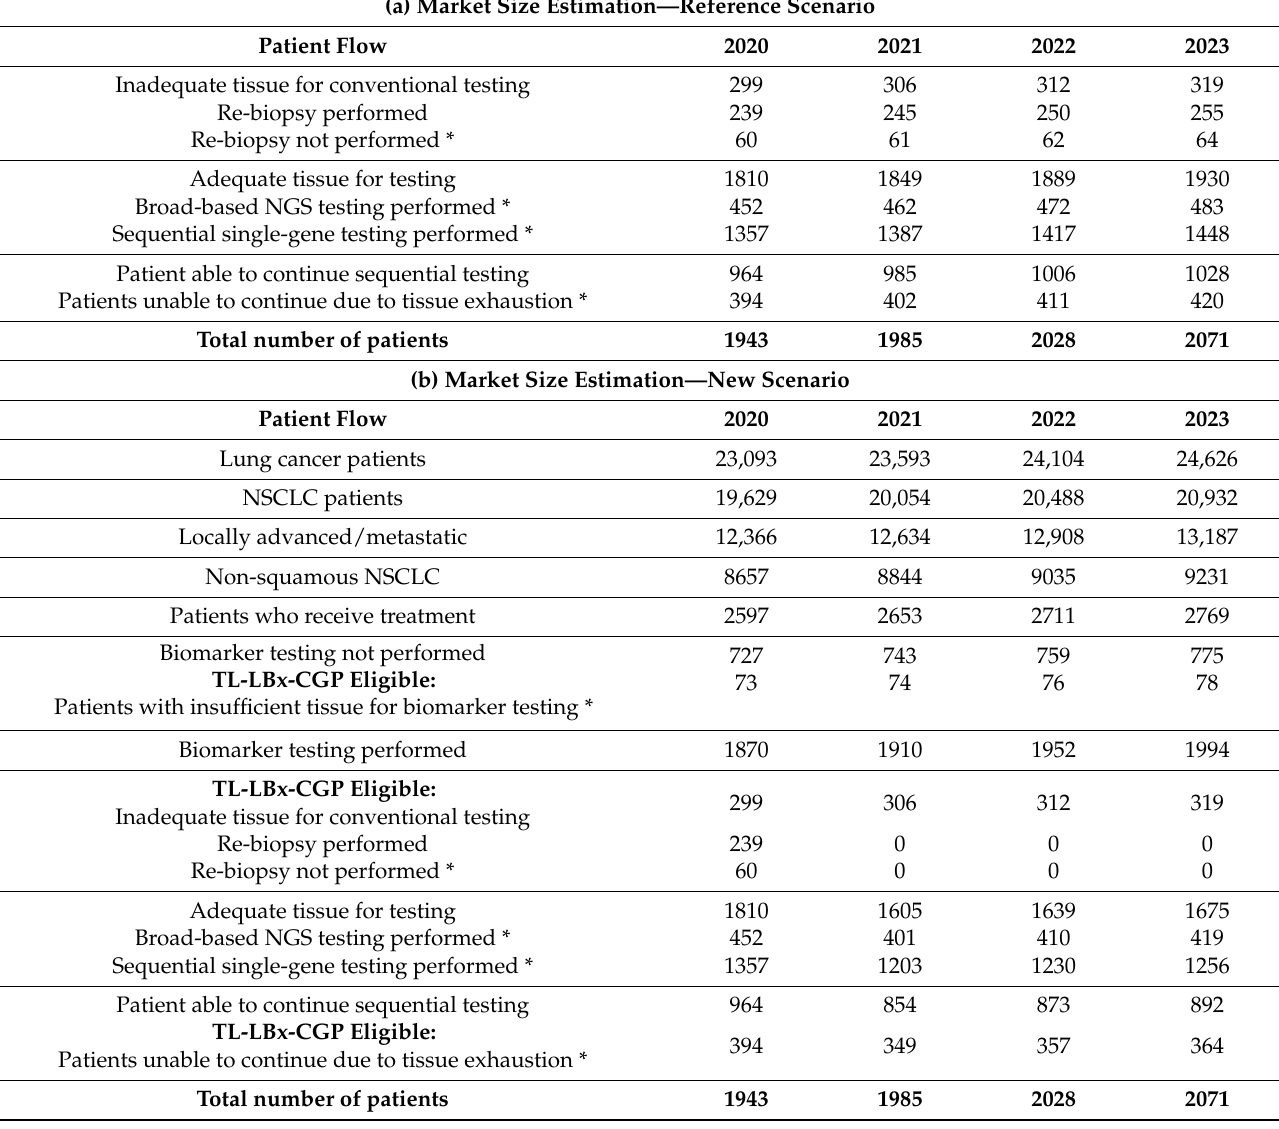
Table 1. Cont. (a) Market Size Estimation—Reference Scenario